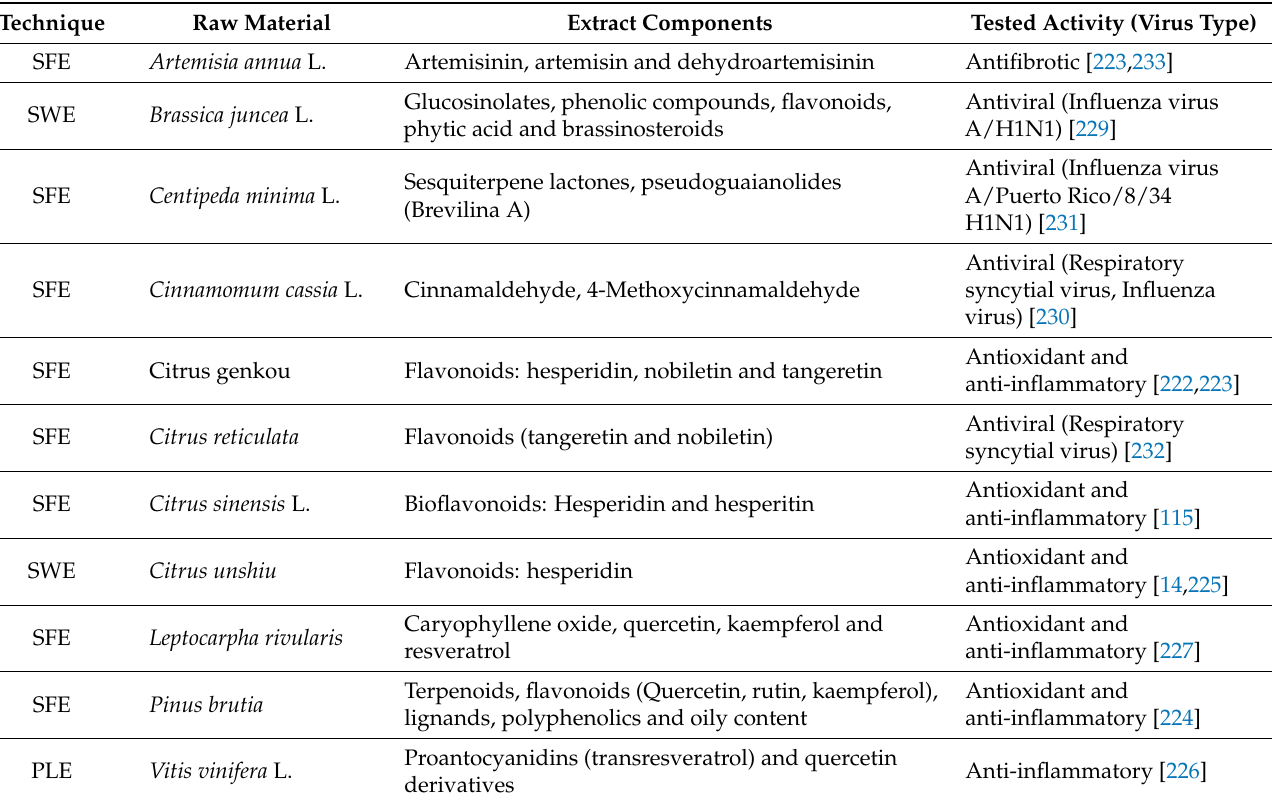
Table 4. Some natural components obtained with compressed fluids and their possible activity against respiratory